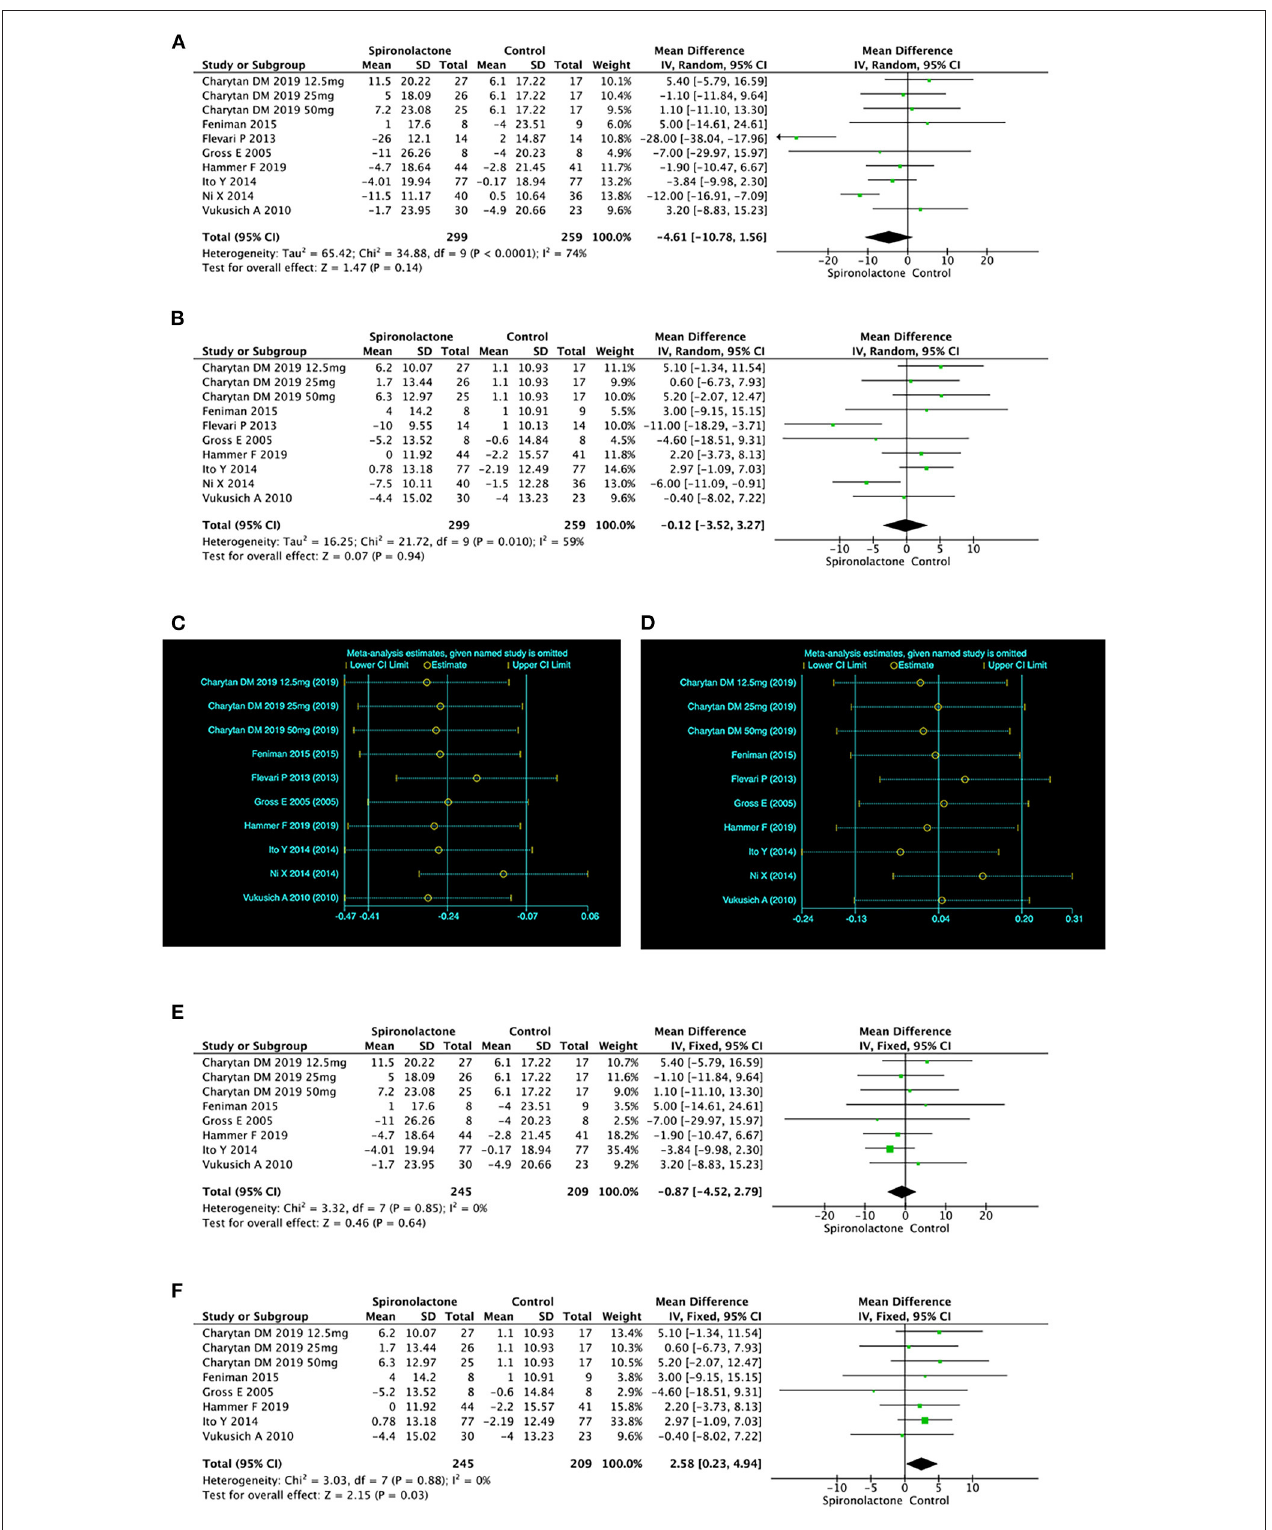
FIGURE 6 | (A) Effect of spironolactone on SBP; (B) Effect of spironolactone on DBP; (C) Sensitive analysis of SBP; (D) Sensitive analysis of DBP; (E) Effect of spironolactone on SBP after sensitive analysis; (F) Effect of spironolactone on DBP after sensitive analysis. DBP, diastolic blood pressure; SBP, systolic blood pressure.